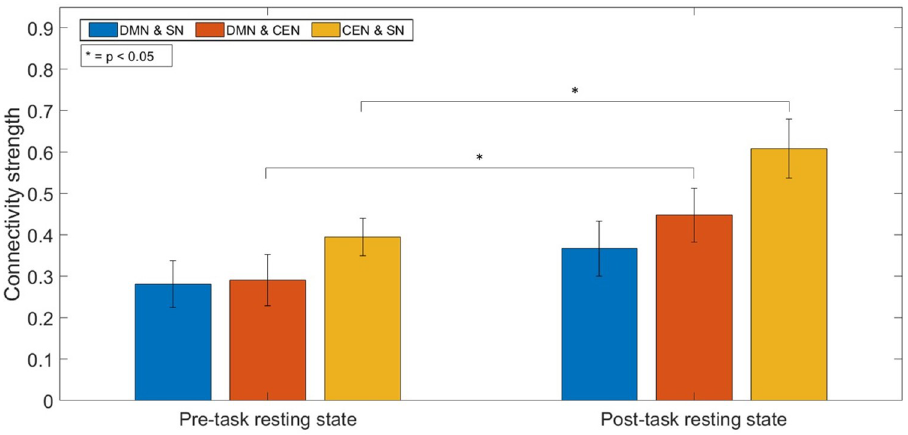
Fig 5. Strength of the FC between each pair of networks in the triple network in the pre- and post-task resting- state. There is a significant increase in FC between the DMN and CEN, and between the CEN and the SN in the post- task resting-state (p < 0.05). The bars represent the standard